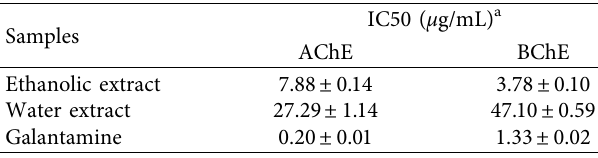
Table 1: Cholinesterase inhibitory activities of C. spectabilis fower extracts and